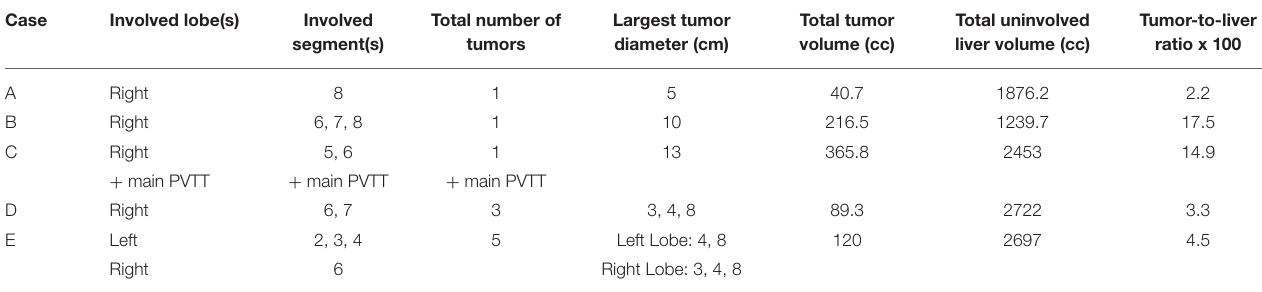
TABLE 2 | Tumor and liver characteristics of 5 cases planned with X-ray therapy (XRT) and proton beam therapy (PBT).